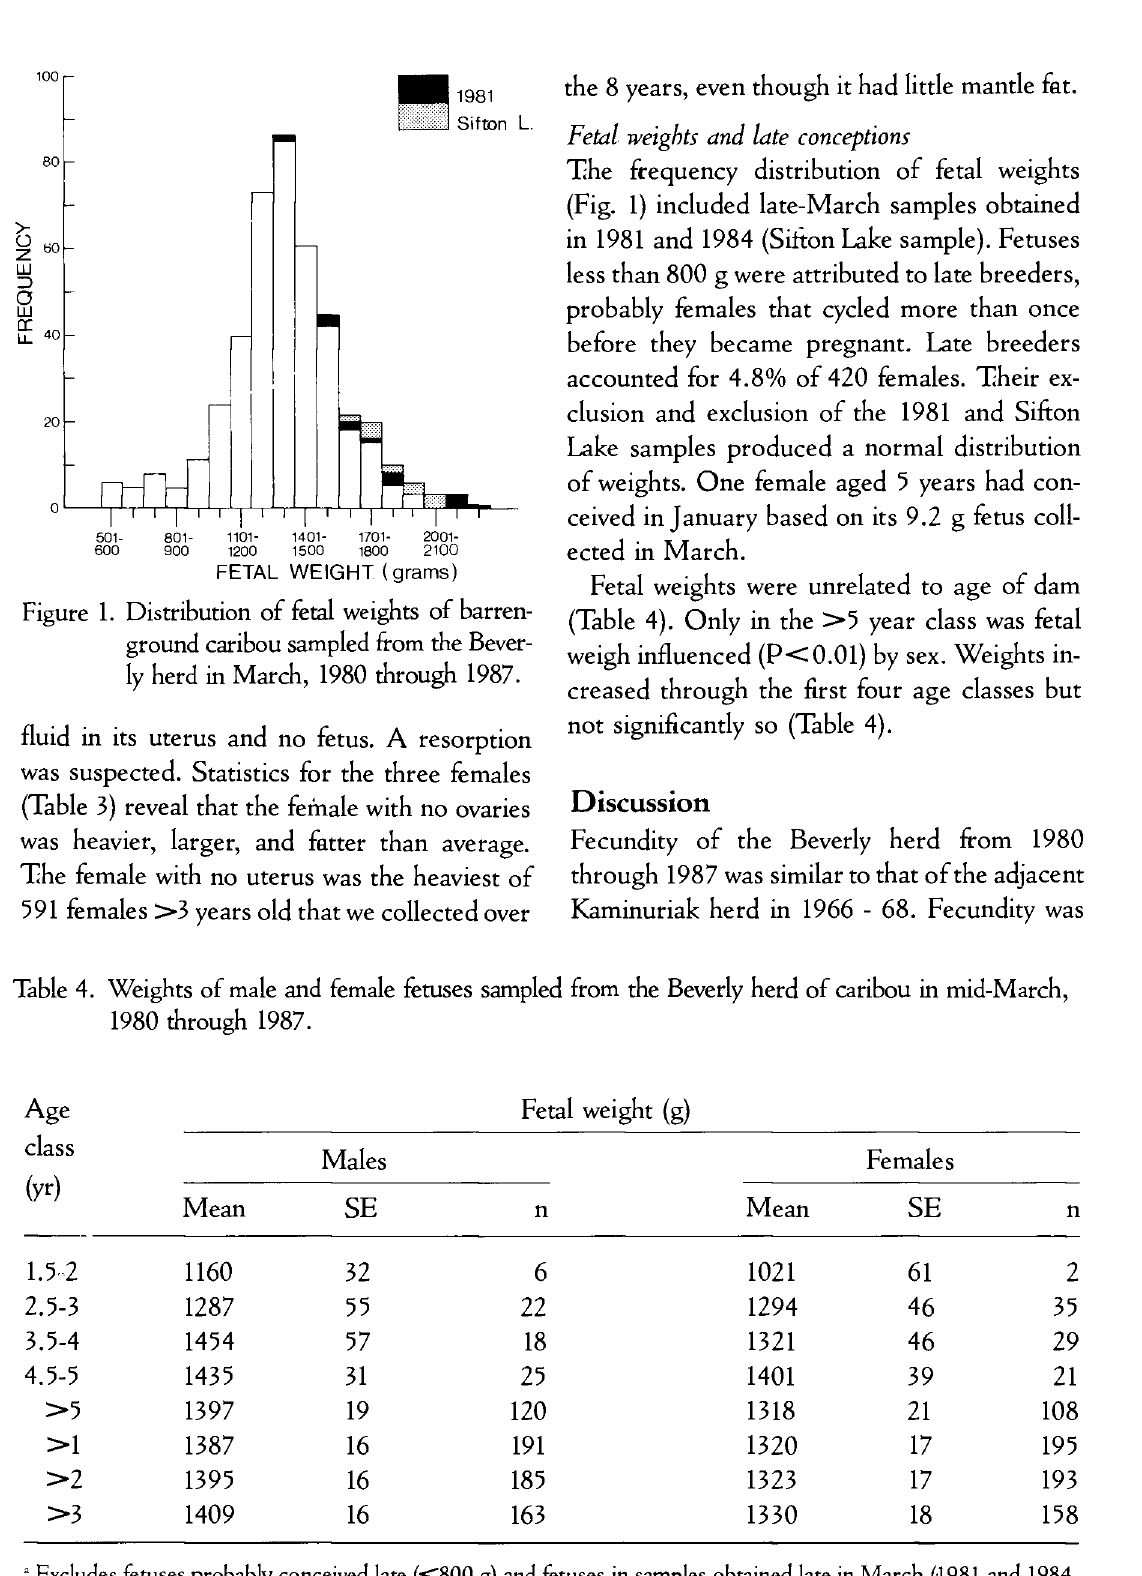
Table 4. Weights of male and female fetuses sampled from the Beverly herd of caribou in mid-March, 1980 through 1987.